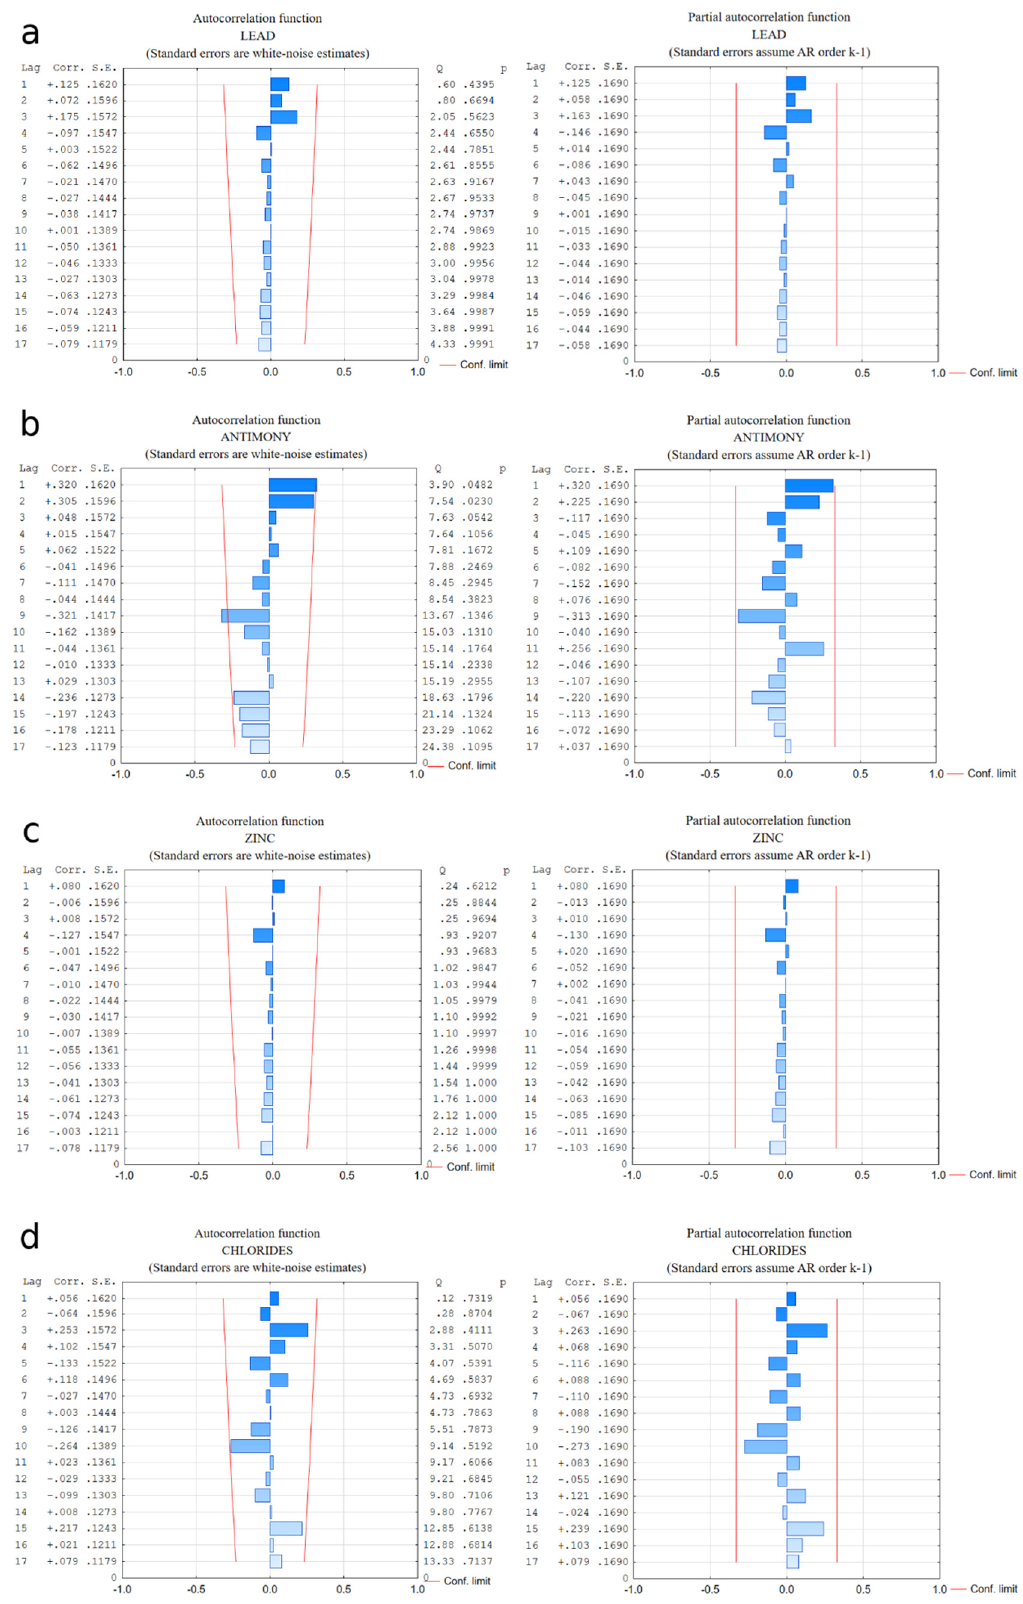
Figure 5. Analysis of seasonality (ACF and PACF; barium, chromium, antimony, and TDS).